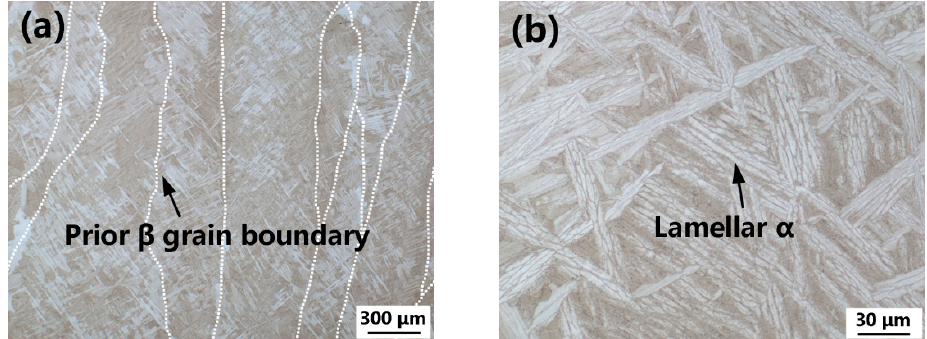
Figure 5. Cross-sectional macrostructure ( a ) and microstructure ( b ) of the as-deposited Ti60 alloy. The prior β grain boundaries in ( a ) were traced in white dots.